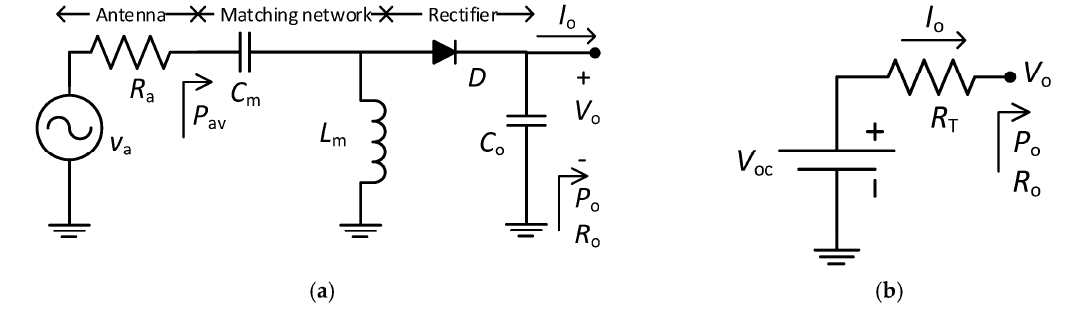
Figure 2. Rectenna: ( a ) Schematic circuit; ( b ) Thévenin equivalent